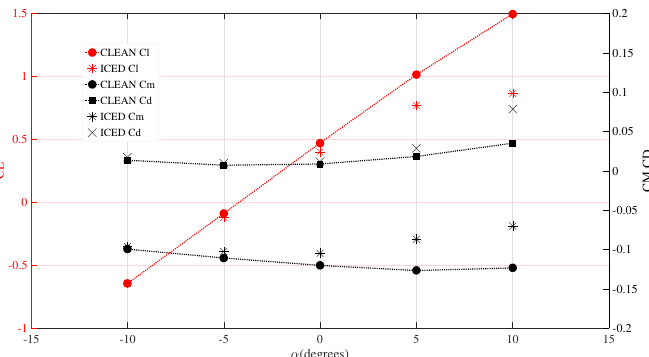
Figure 10. Icing effect on the aerodynamic coefficients at Section